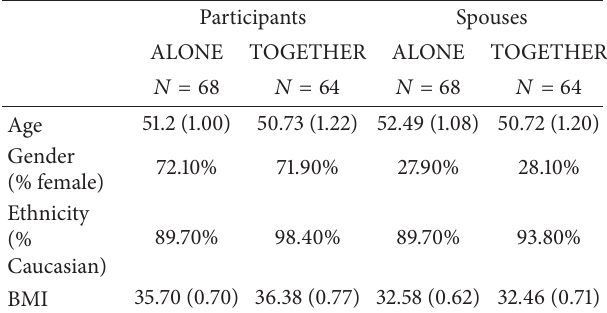
Table 1: Demographics of participants and spouses, mean (SE), %.